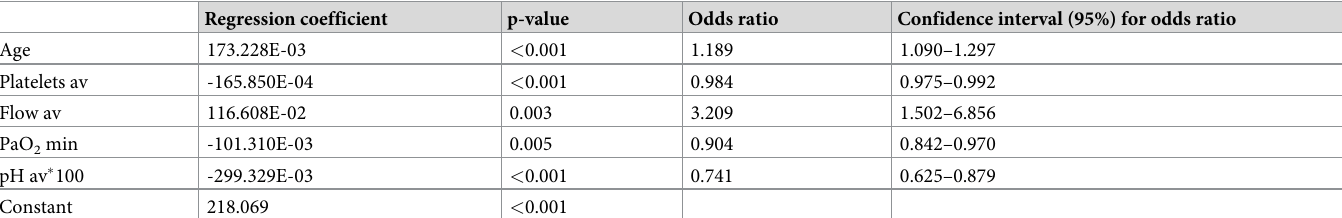
Table 4. Regression coefficients, significance, and odds ratio with confidence interval for the regression model calculated with the parameters age, average platelet count on day 10 (Platelets av), average pump flow rate on day 10 (Flow av), minimum partial pressure of oxygen on day 10 (paO 2 min), and average pH on day 10, multiplied by 100 (pH av � 100).